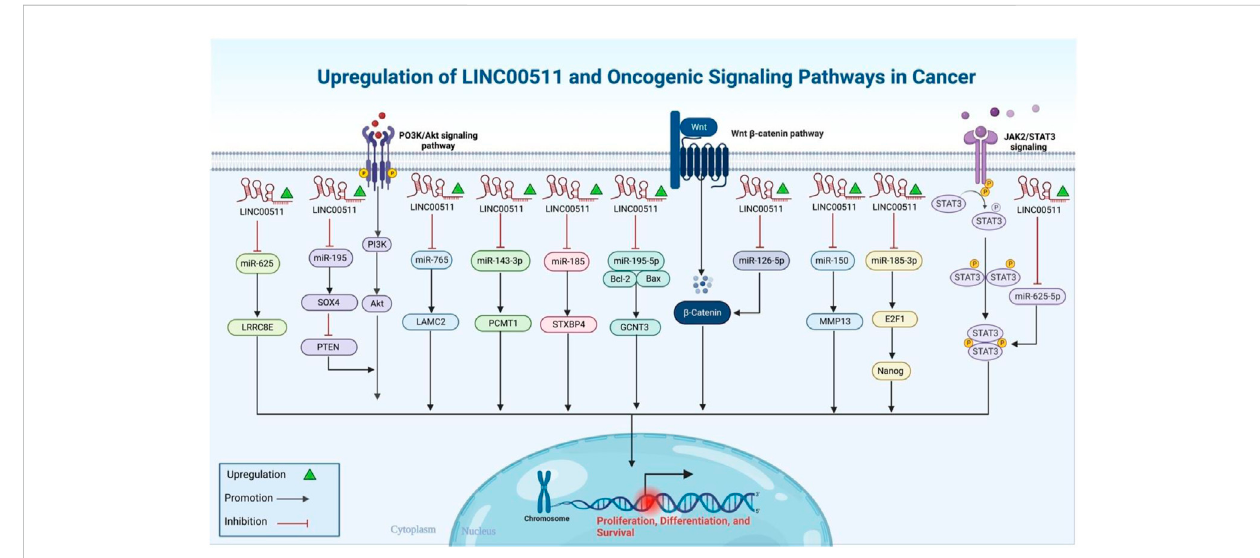
FIGURE 1 A graphical illustration of the oncogenic role that LINC00511 performs in the environment of the many types of cancer.